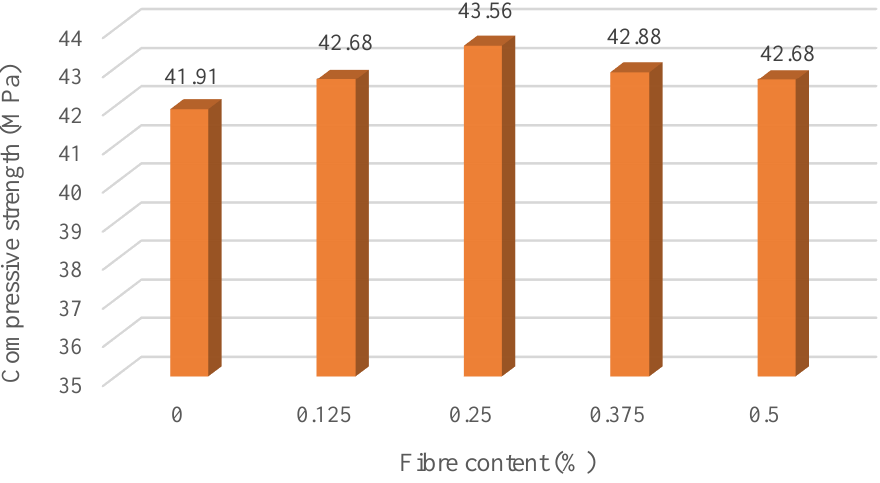
Figure 4. Compressive strength under different mixes.